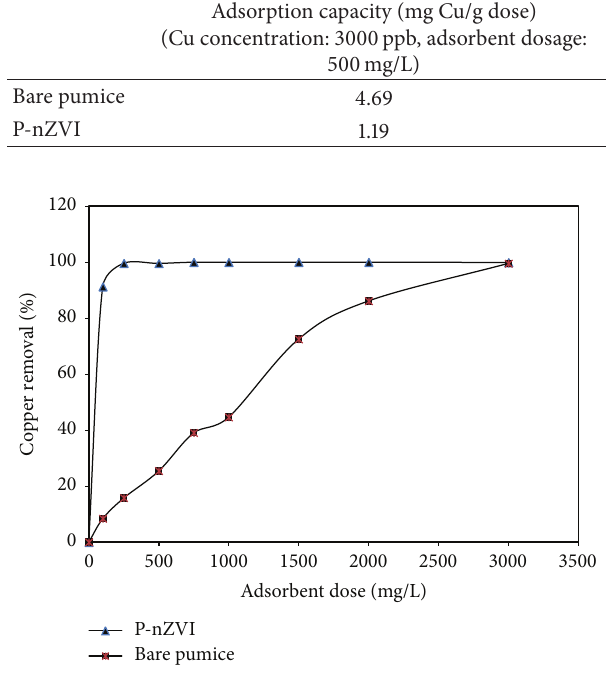
Figure 5: The effect of nZVI coating on copper removal (equi- librium time: 4h; temperature: 20 ∘ C, 150rpm; pH: 8.0; copper concentration: 3000 ppb).